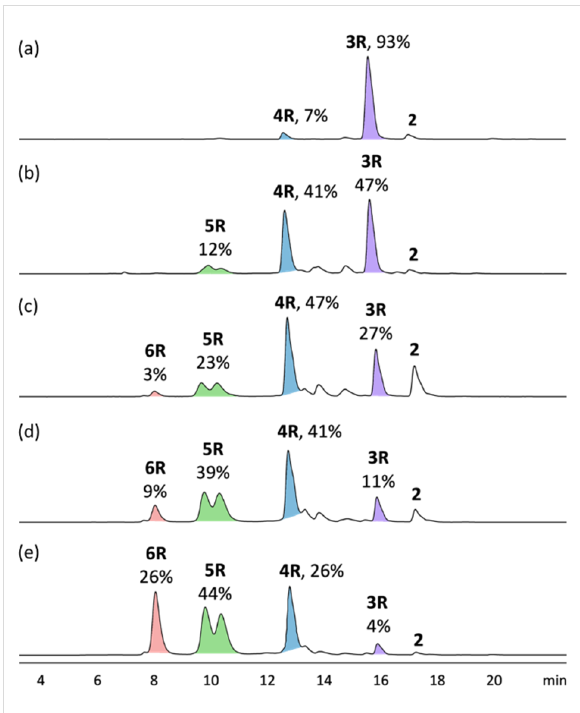
Figure 1: LC–MS analysis of the reaction mixture of the [ n ]rotaxane synthesis in the presence of (a) 0.5; (b) 5; (c) 10; (d) 20; and (e) 50 equiv of γ